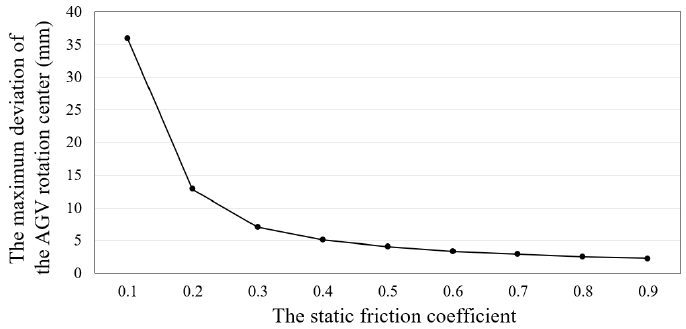
ff erent static friction coe ffi